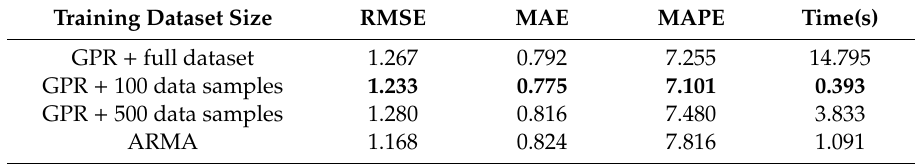
Table 2. Comparison of the proposed models built with two datasets in Y(2)